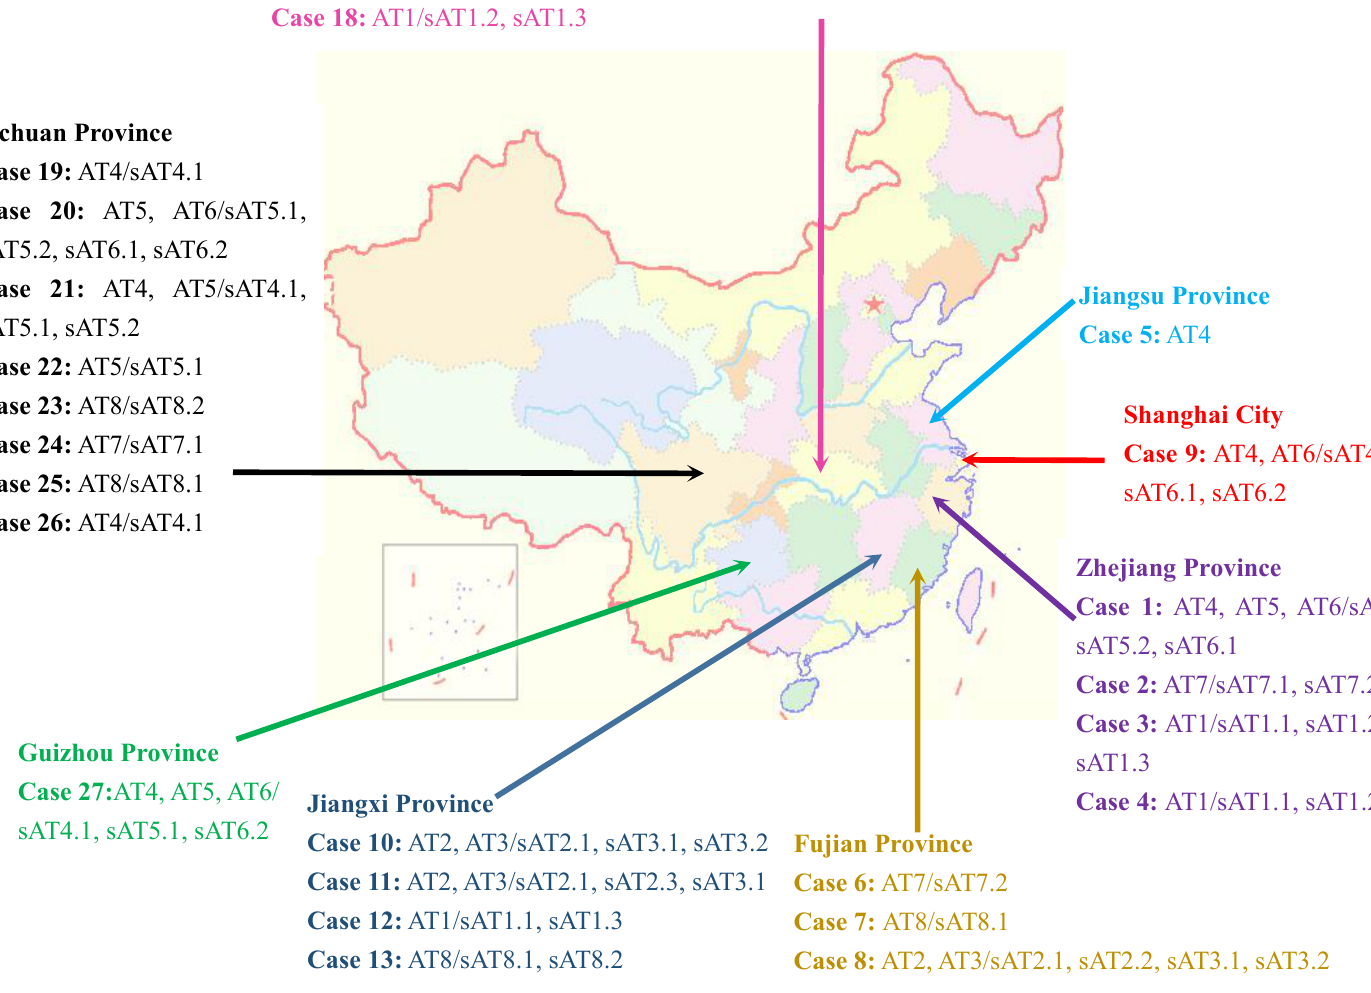
Fig. A2.1: First-hand cases, regions and archetypes